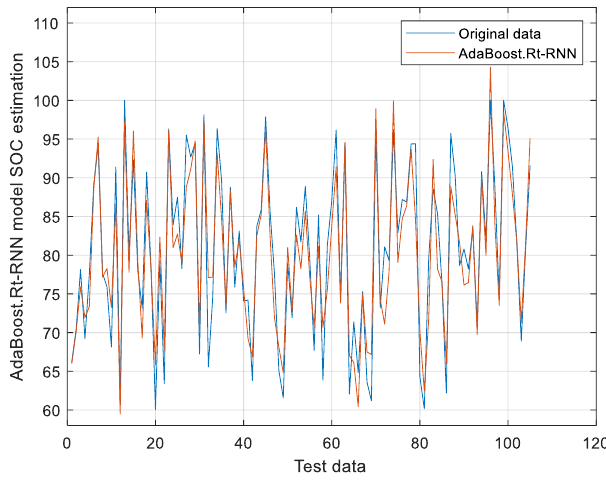
Figure 10. AdaBoost.Rt-RNN model SOC estimation comparison